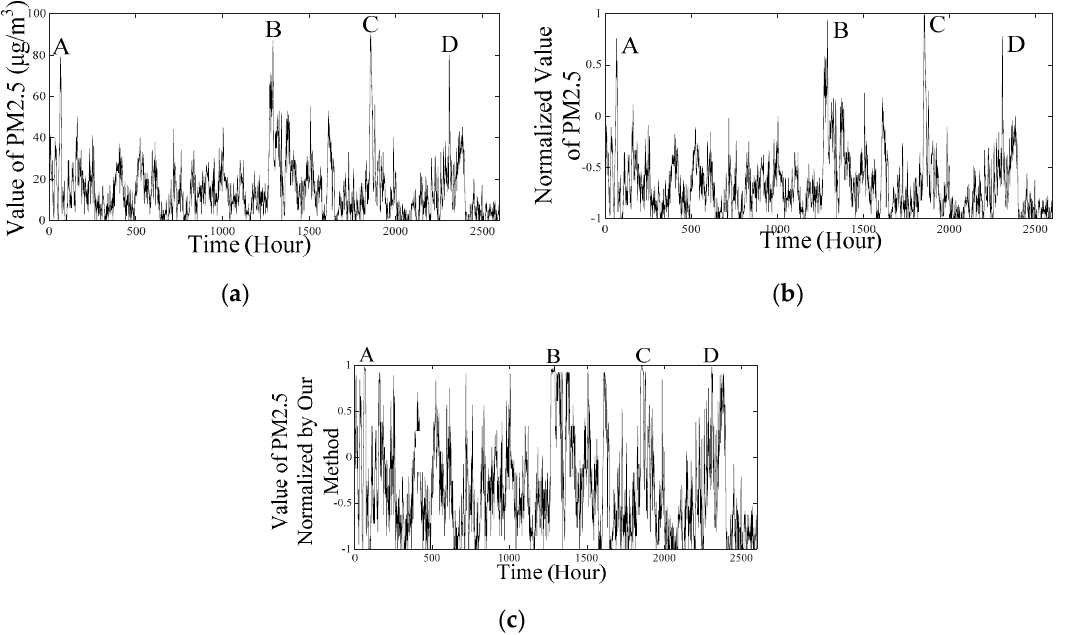
Figure 7. Graphs explain the principle of usual case emphasizing normalization method (UCENormalization): ( a ) original dataset; ( b ) results of general normalization and ( c ) results of UCENormalization.